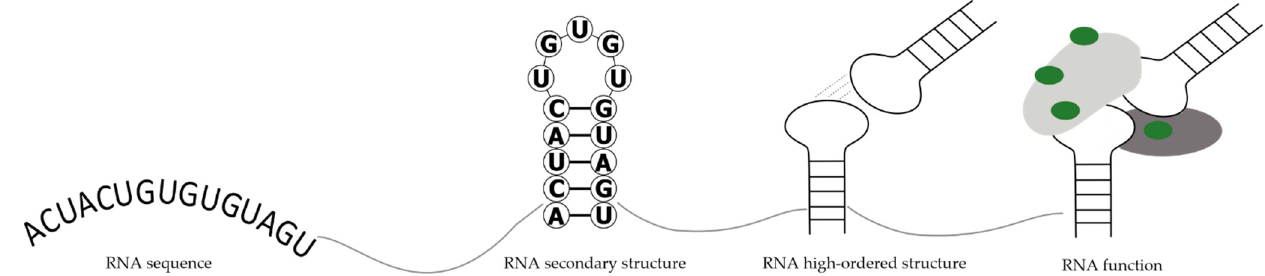
Figure 1. Scheme of the relationship between RNA sequence, structure and function.